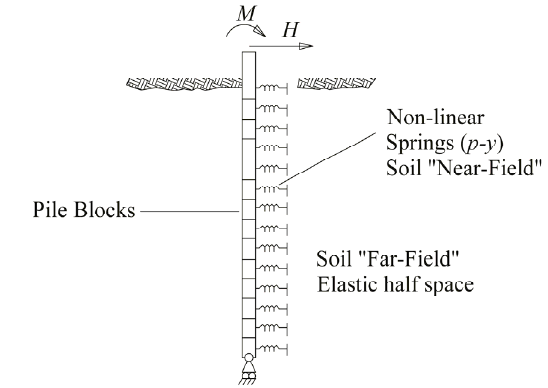
Figure 5. Hybrid BEM ‐ p ‐ y method.